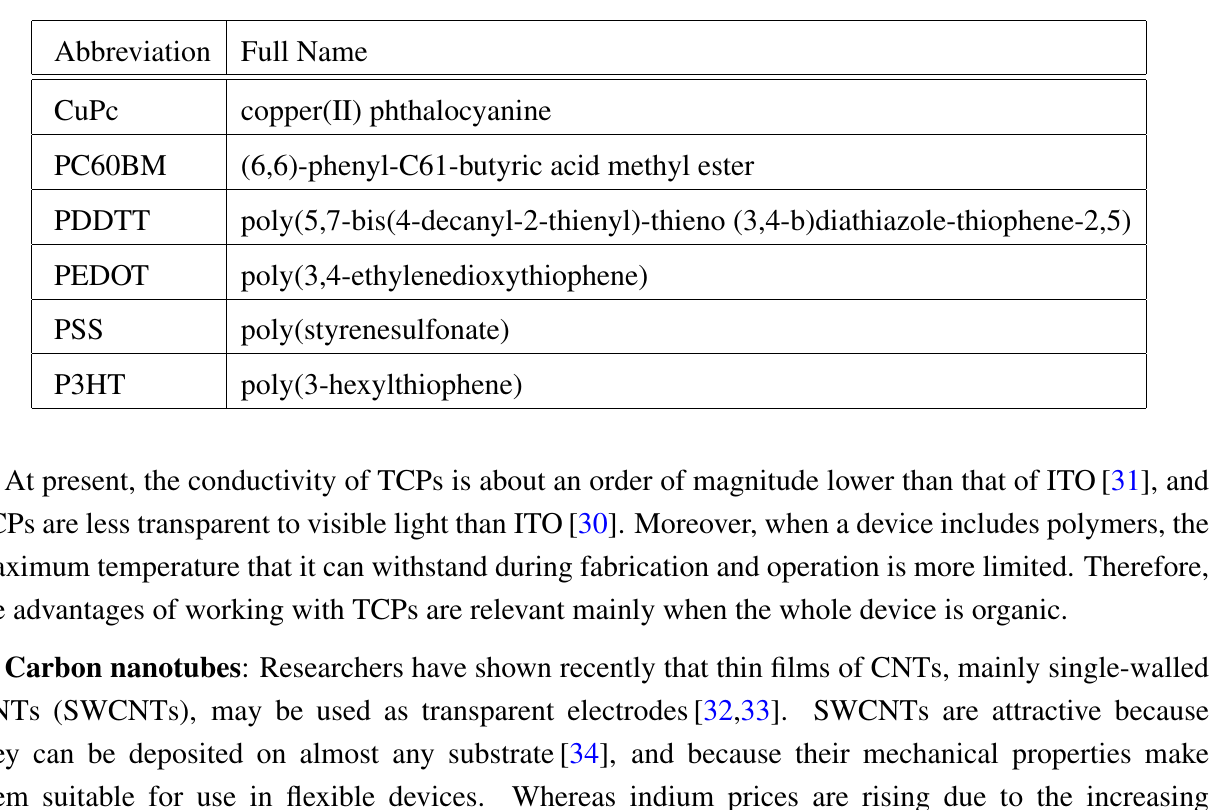
Table 3. Abbreviations and full names of polymers commonly used in organic electronic